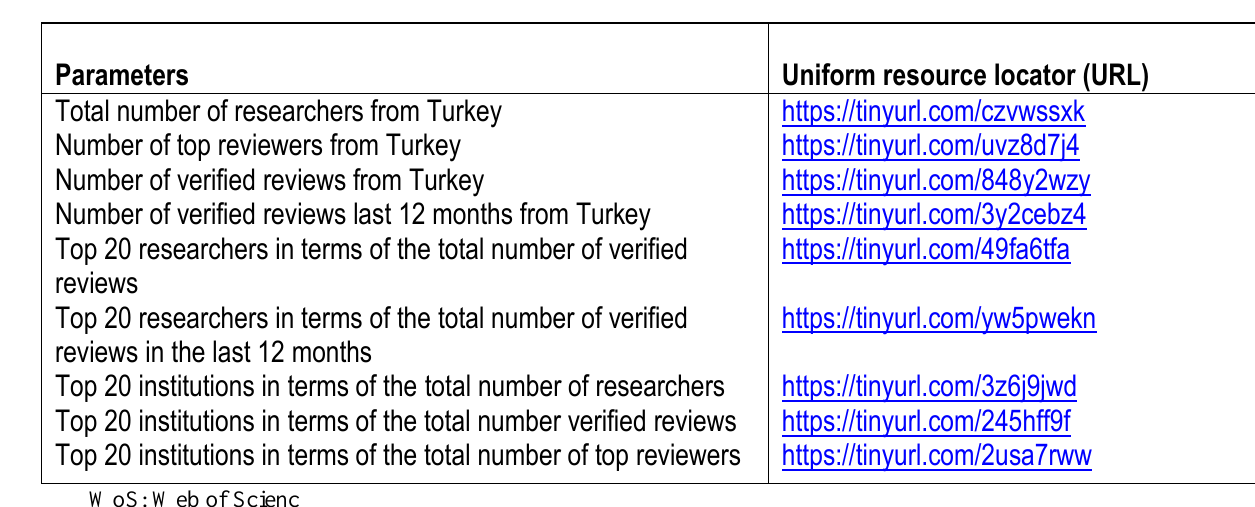
Table 1. Publons links used to obtain